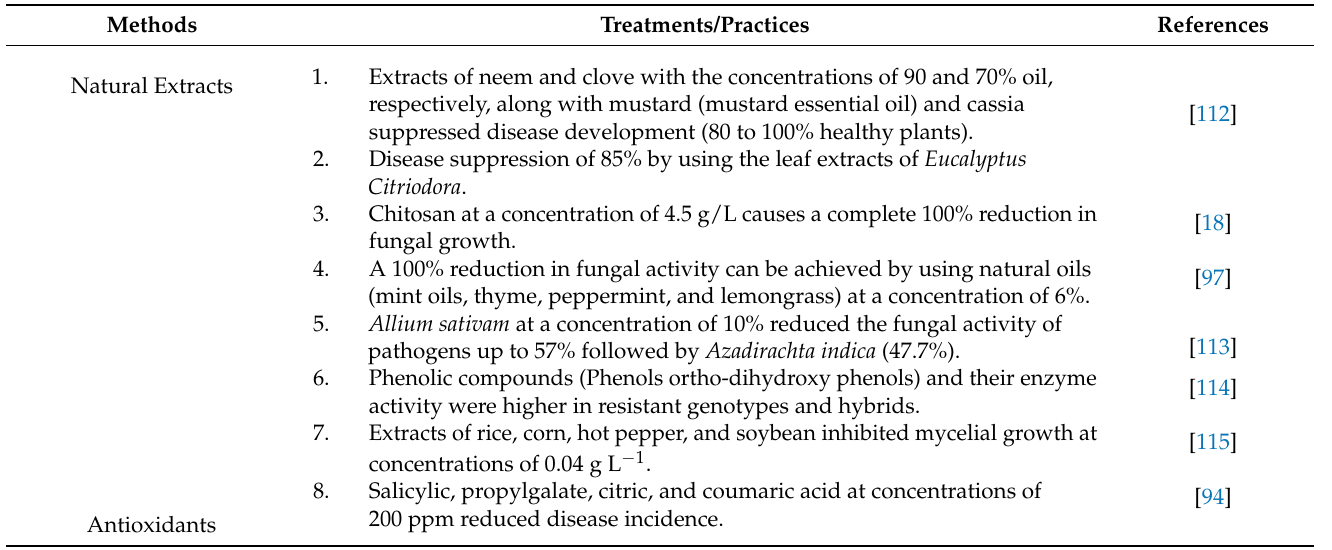
Table 5. Integrated disease management to control the wilt disease of chilies. Methods